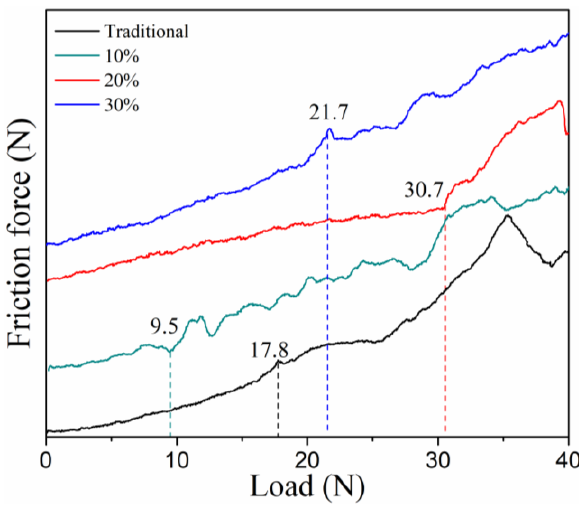
Figure 5. Traditional and laser cleaning pretreatment coatings ’ adhesions.